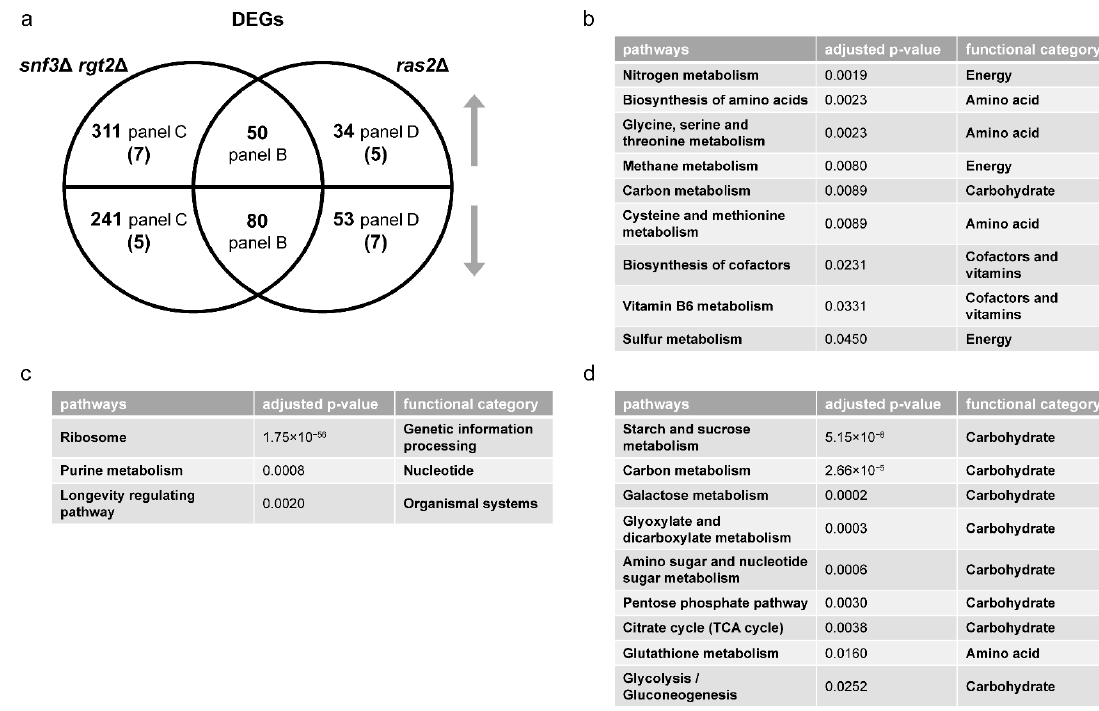
Figure 8. Comparing differentially expressed genes (DEGs) of snf3 Δ rgt2 Δ and ras2 Δ . ( a ) Venn diagram of subsets of DEGs, for snf3 Δ rgt2 Δ vs. wildtype and ras2 Δ vs. wildtype, after glucose addition to 2%. Upper semicircle shows up-regulated DEGs and lower semicircle shows down-regulated DEGs. Numbers in the overlapping region are shared DEGs regulated in the same direction. Numbers in parenthesis are shared DEGs regulated in the opposite direction, and are placed in the area corresponding to the direction of regulation. DEGs used for ORA analysis that are ( b ) shared and change in the same direction; ( c ) unique to snf3 Δ rgt2 Δ ; ( d ) unique to ras2 Δ . Listed are all pathways and their functional categories with adjusted p -value < 0.05.